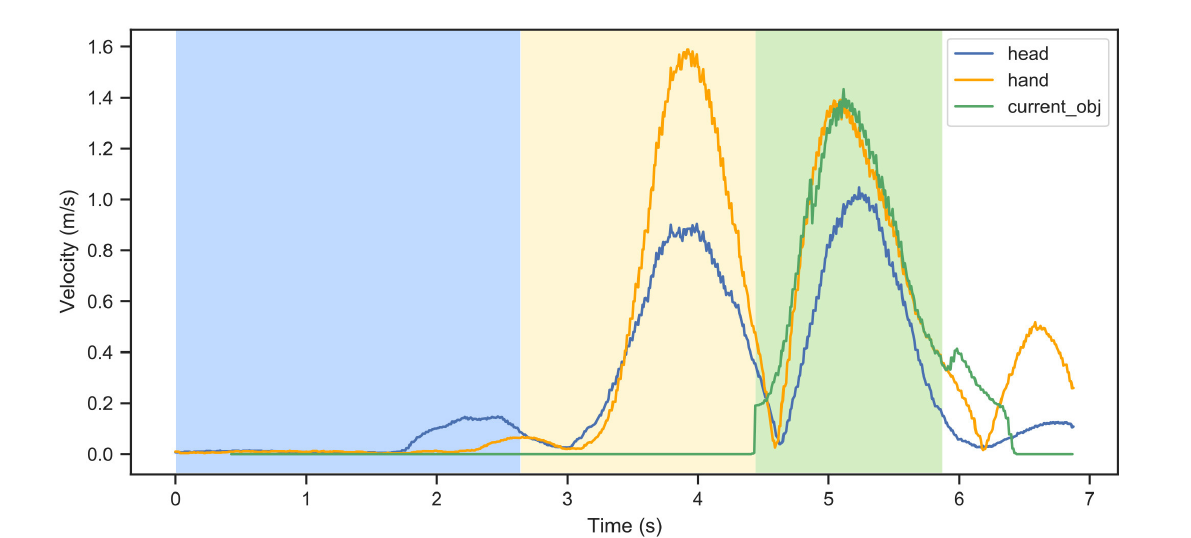
FIGURE6 An example of velocities as a function of the trial duration for one participant in one trial: different curves represent the head, the hand, the target object, and the end target, respectively. The colored sectors correspond to the search (blue), reach (yellow), and transport (green) phases. In this example, the task was completed in approximately